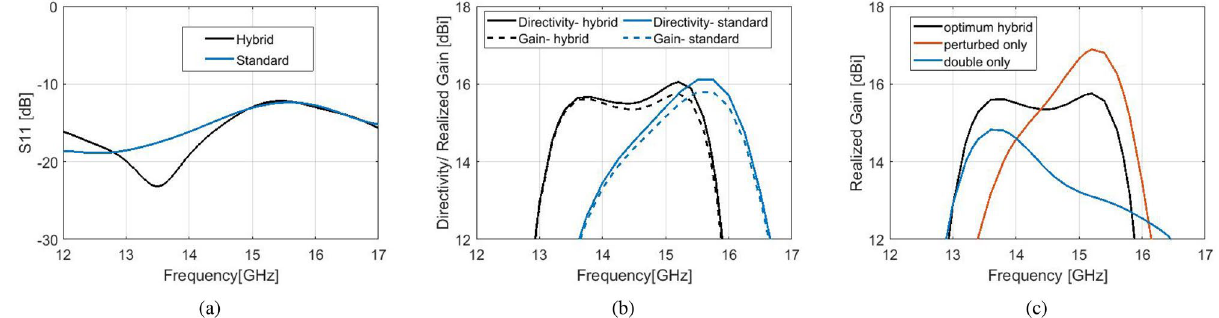
Figure 6. Simulated results of the optimum hybrid Bull’s Eye antenna with flat gain compared to a standard Bull’s Eye antenna ( N = 6 ) of similar gain. ( a ) S 11 . ( b ) Directivity and realized gain. ( c ) Contribution of each corrugation type in the hybrid effect.